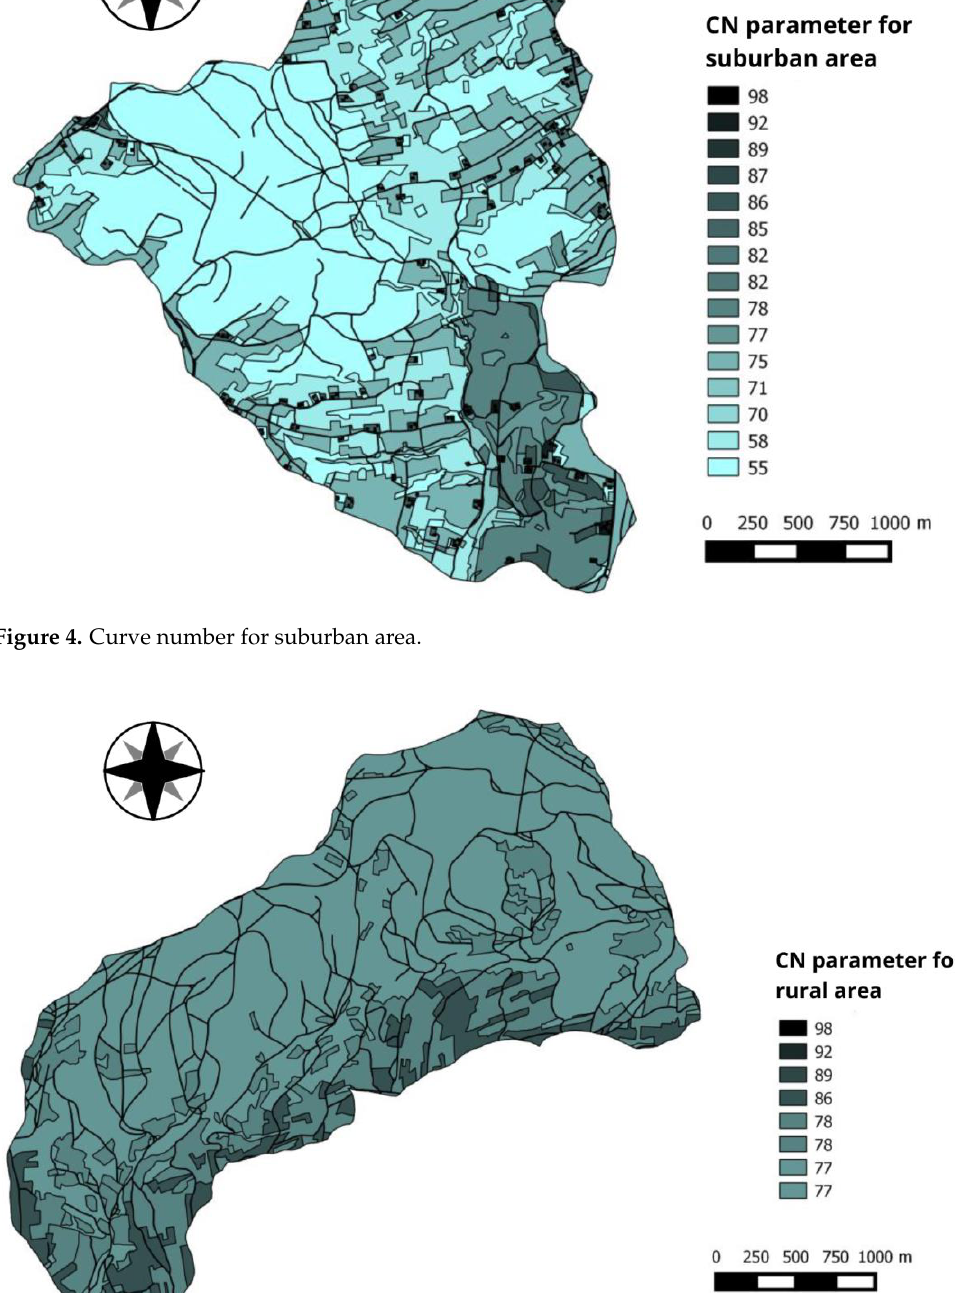
Figure 5. Curve number for rural